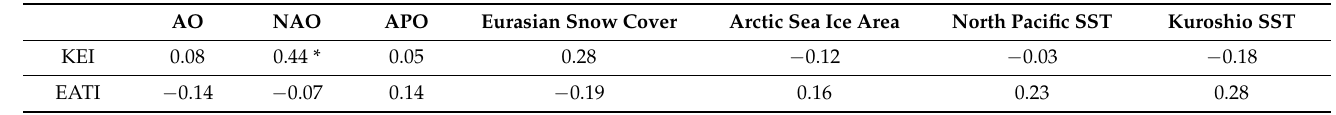
Table 1. Pearson correlation coefficients between KEI in OND/EATII in DJF and important indices in OND, including the Arctic Oscillation (AO), North Atlantic Oscillation (NAO), Asian-Pacific oscillation (APO) teleconnection pattern indices, Eurasian snow cover (60–140 ◦ E, 40–65 ◦ N), Arctic sea-ice area (30.5–149.5 ◦ E, 72.5–83.5 ◦ N), North Pacific SST (120–180 ◦ E, 26–40 ◦ N), and Kuroshio SST (120–150 ◦ E, 20–40 ◦ N). The asterisk indicates the coefficient passing the 90% confidence level. The AO, NAO, and APO indices are from the Physical Sciences Laboratory of National Oceanic and Atmospheric Administration (https://psl.noaa.gov/data/climateindices/list/, accessed on 2 February 2021). APO Eurasian Snow Cover Arctic Sea Ice Area North Pacific SST Kuroshio SST 0.28 − 0.12 − 0.03 − 0.18 − 0.19 0.16 0.23